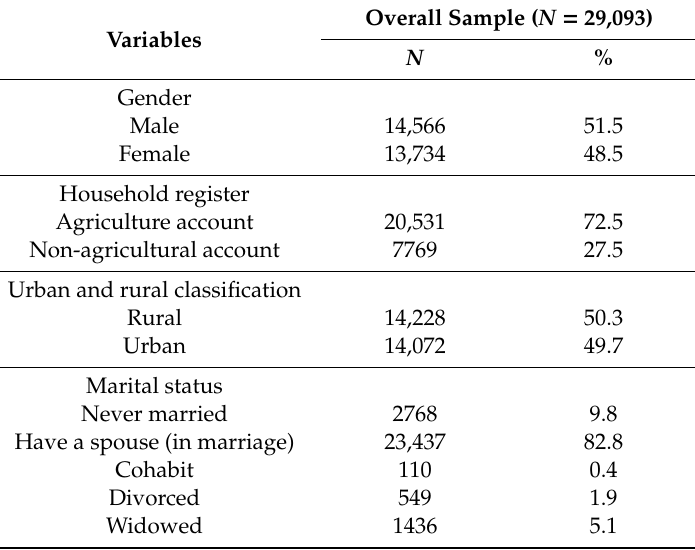
Table 1. Demographic characteristics of